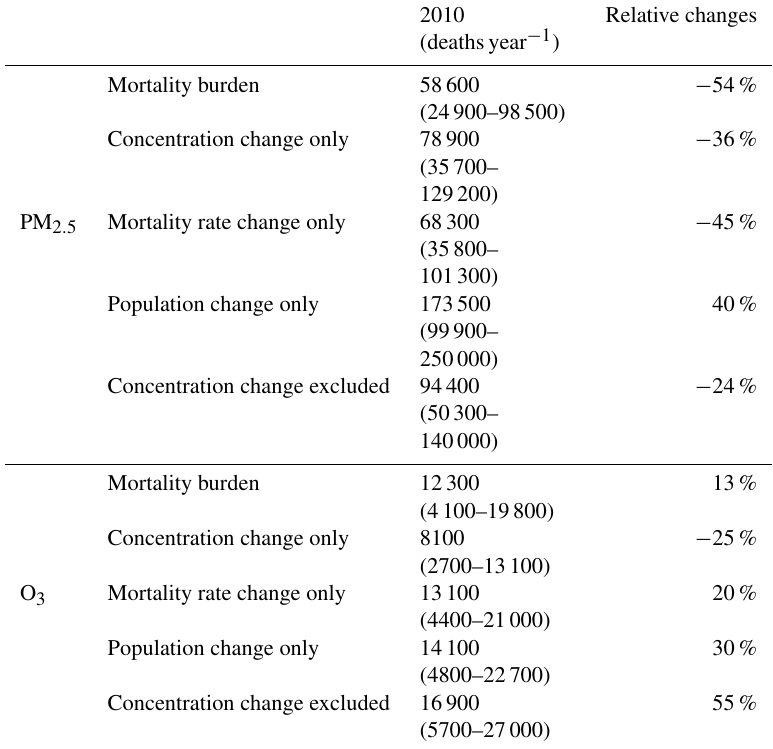
Table 1. The total mortality burdens in 2010 and the burdens in 2010 due to changes since 1990 in each of three factors (concentration, baseline mortality rates and population) and where the concentration change is excluded, for PM 2 . 5 and O 3 , and the relative changes between 2010 and 1990. The relative changes are calculated as (2010–1990)/1990. The mortality burdens in the US for PM 2 . 5 and O 3 in 1990